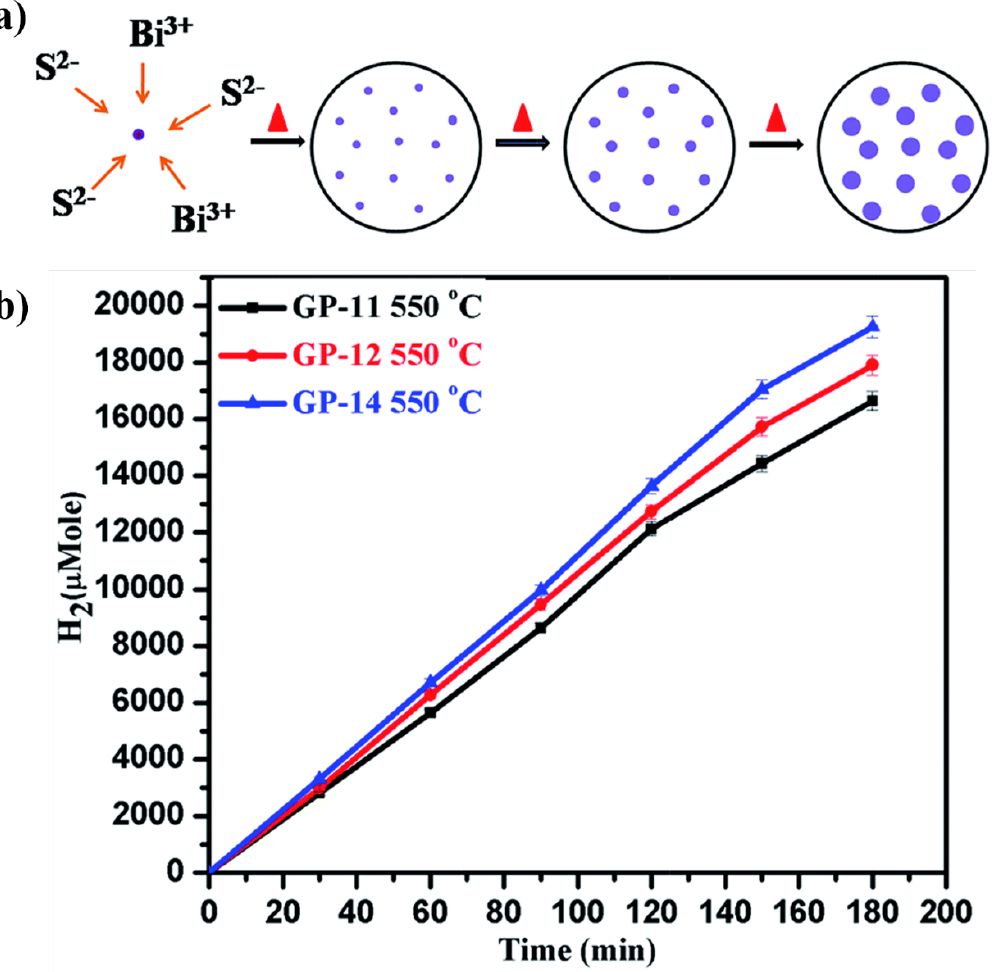
Figure 21. ( a ) Schematic diagram of the formation and growth mechanism of Bi 2 S 3 QDs in a glass matrix. ( b ) Photocatalytic activities of glass composites GP-11, GP-12 and GP-14 obtained by heat treatment at 550 °C for 8 h. Reprinted with permission from Ref. [121].